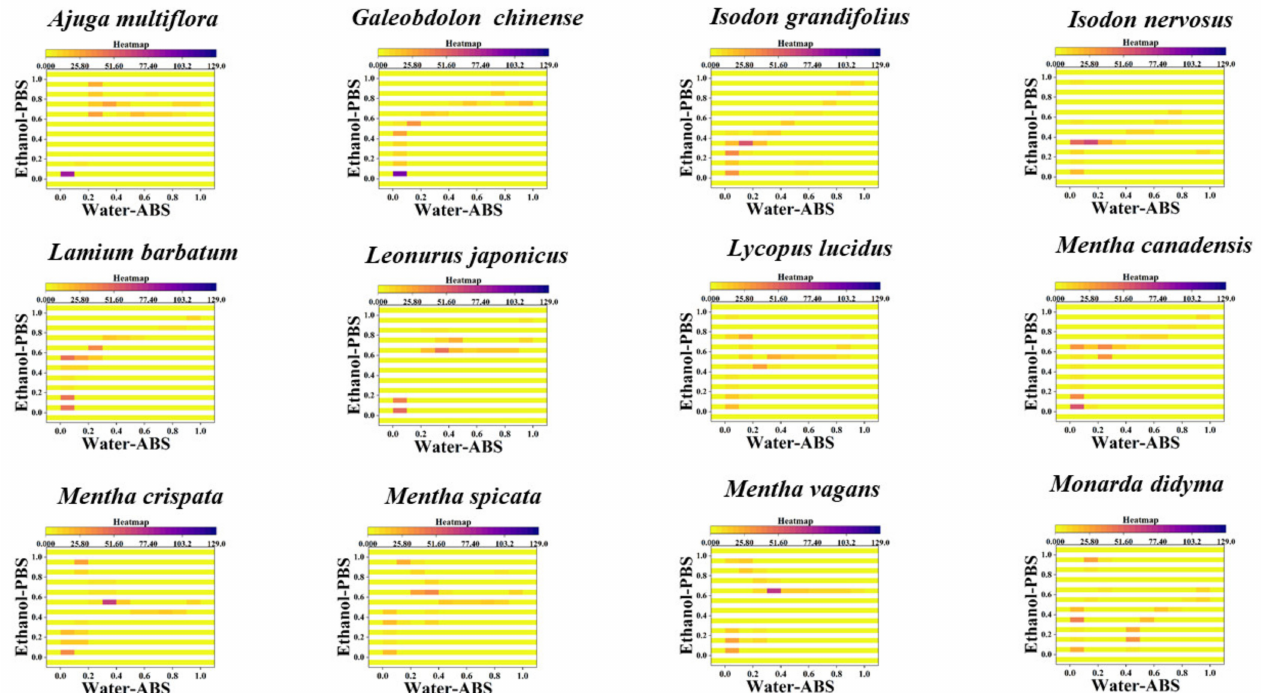
Figure 5. Heatmap of 12 species of Lamiaceae combining the signals collected under PBS for the water extracts and under ABS for the ethanol extracts (the remaining 24 species can be found in the Supplementary